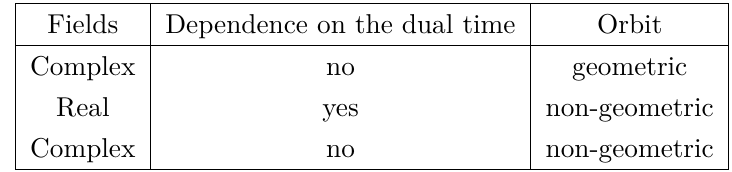
Table 1 . Typical backgrounds generated by a non-abelian fermionic